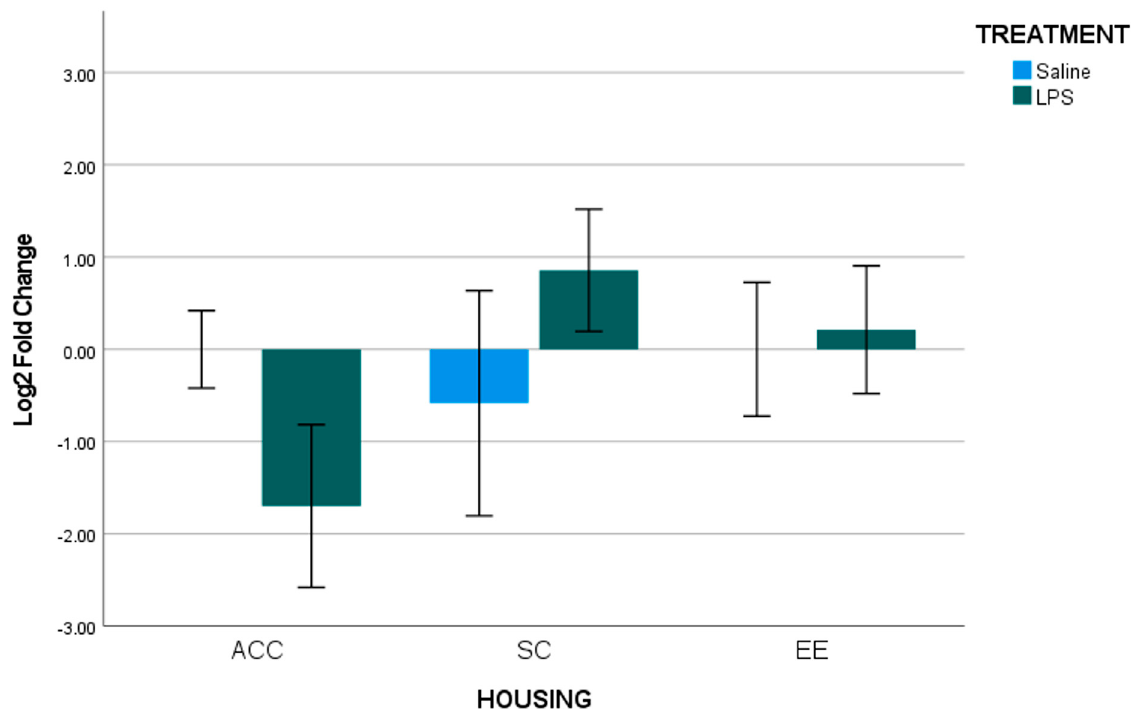
Figure 6. B2 SINE expression for Standard vs. Enriched and Standard vs. Social Control Housing in the Ventral Hippocampus. Standard (Saline: n = 12, LPS: n = 10), Enriched (Saline: n = 12, LPS: n = 14), Social Control (Saline: n = 13, LPS: n = 15). A two-way ANOVA revealed there were no simple main effects from housing or treatment. There were no statistically significant